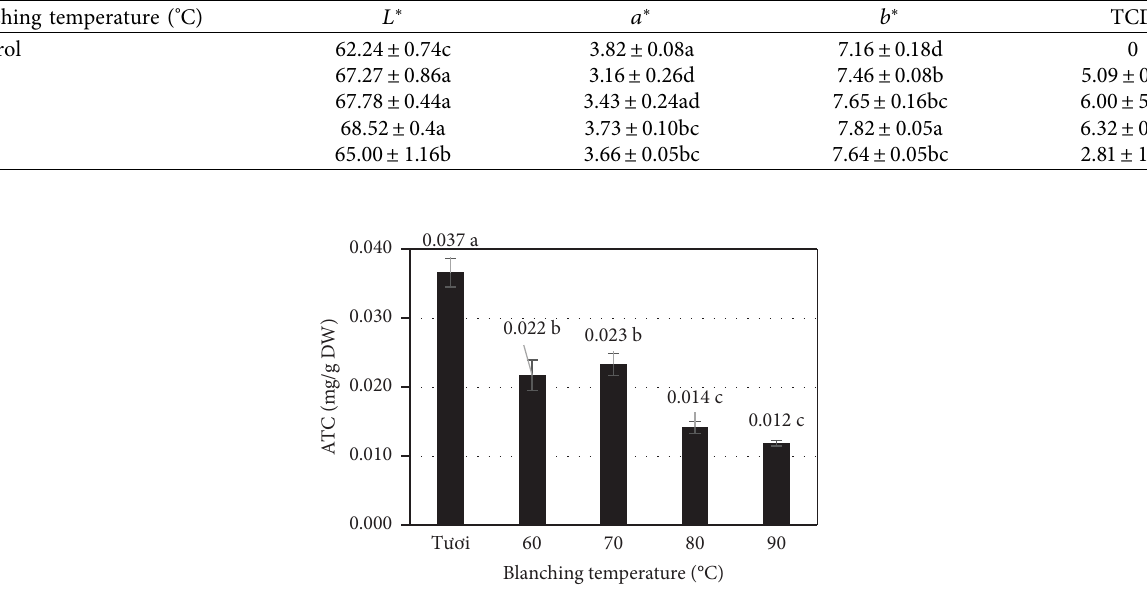
Figure 4: Efect of blanching temperature on astaxanthin content.